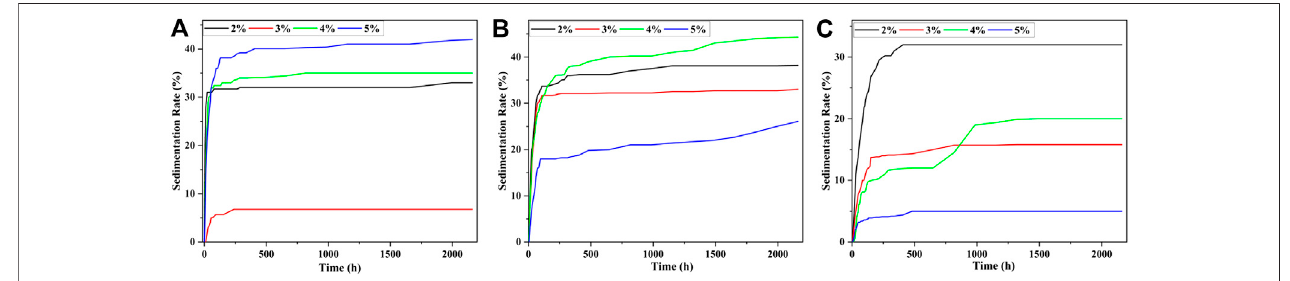
FIGURE 7 | The settling rate when the surfactant is SDS; the mass fraction of CI was (A) 40%, (B) 50%, and (C) 60%.